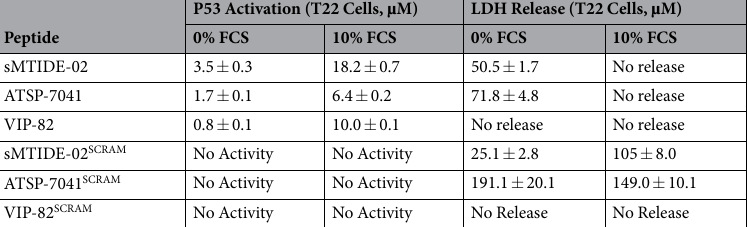
Table 1. p53ACT 50 and LDH 50 values were determined from 4 parameter fits to 10 point titration